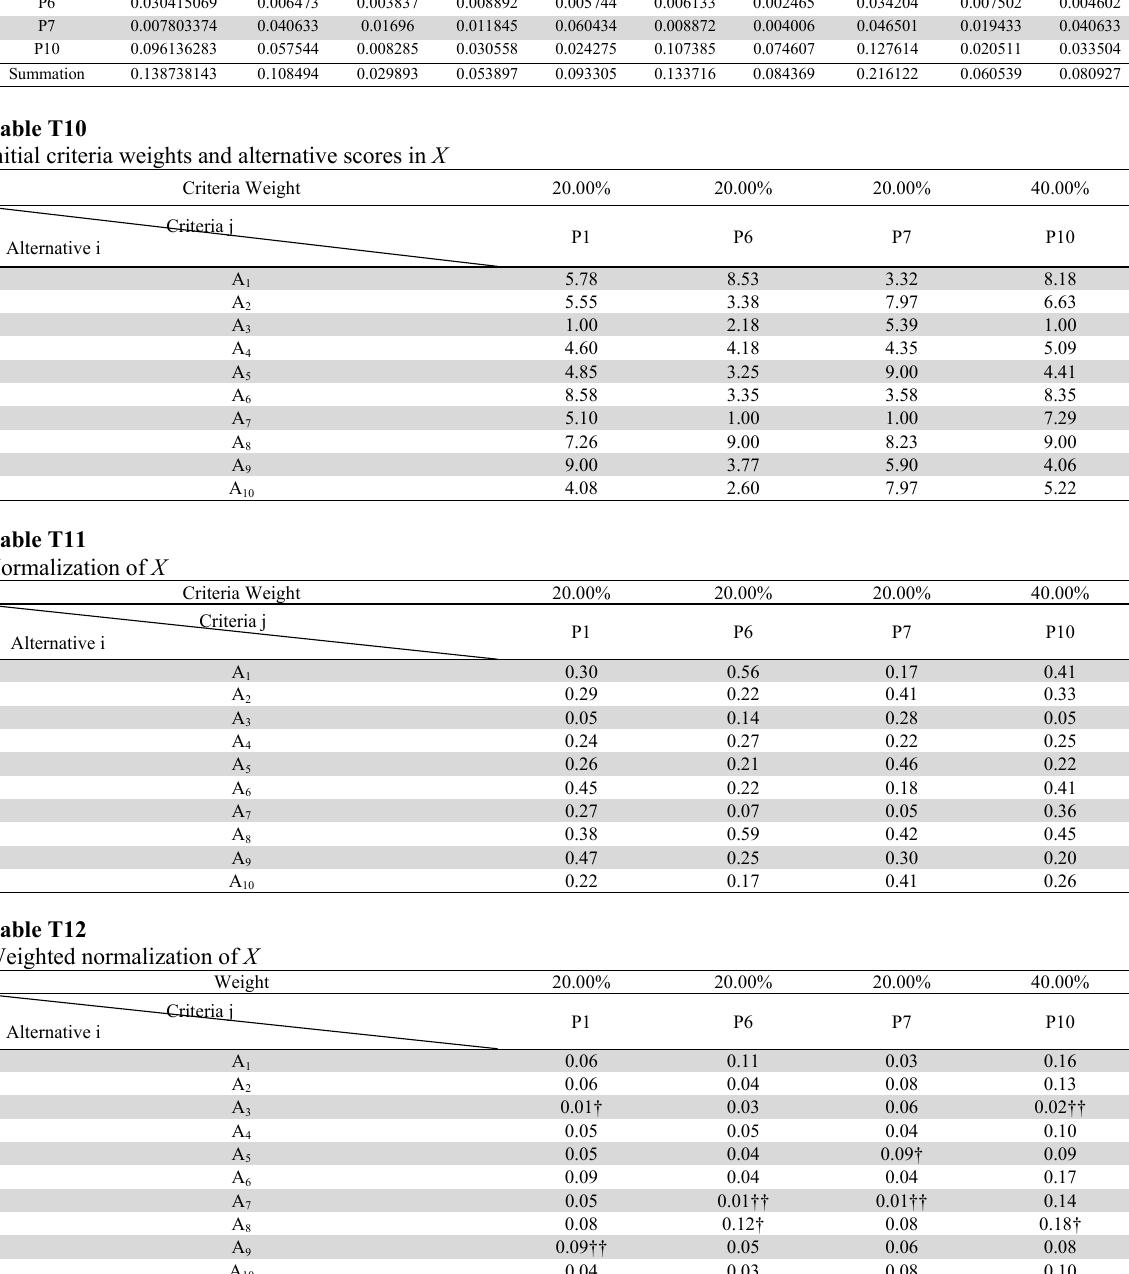
Alternative weights multiplied by related criterion weights and summed Criteria